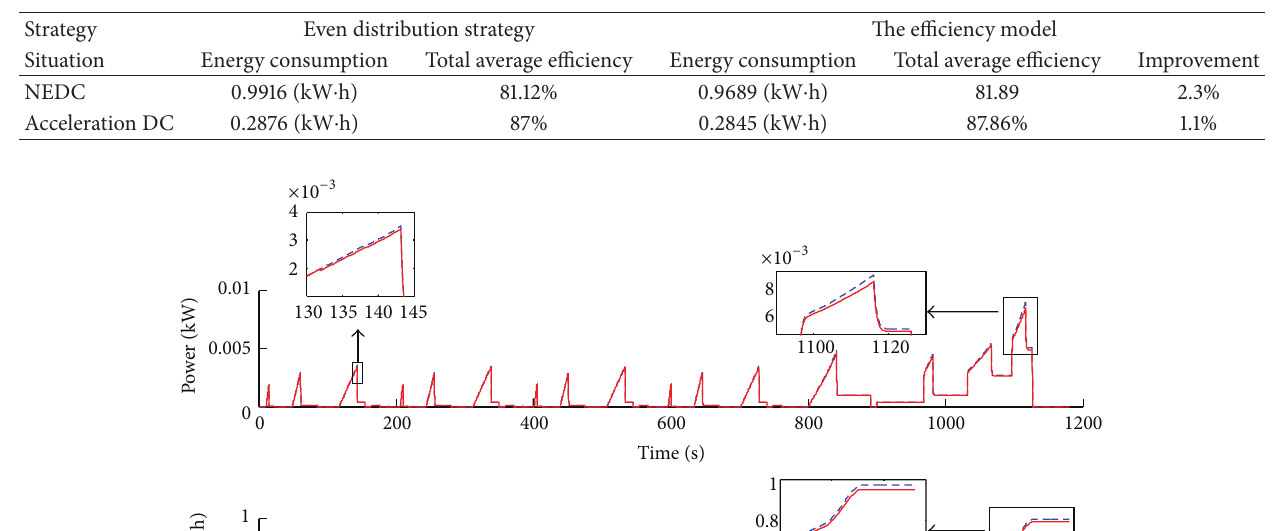
Figure 14: The time history of power and energy consumption over the NEDC.